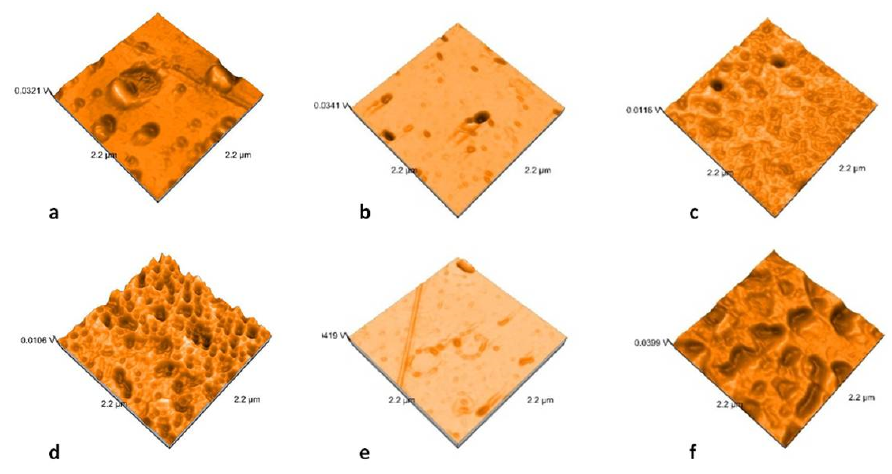
Figure 10. Atomic Force Microscopy (AFM) images of the polished samples: ( a ) LDS-P-P-HT, ( b ) LDS-